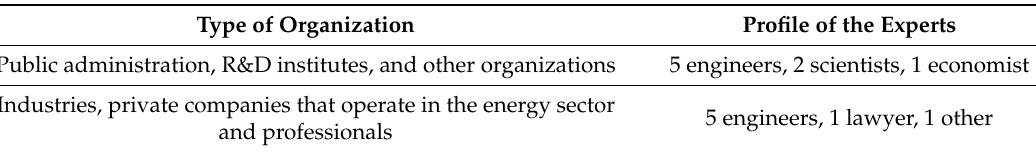
Table 1. Profile of the experts selected as key